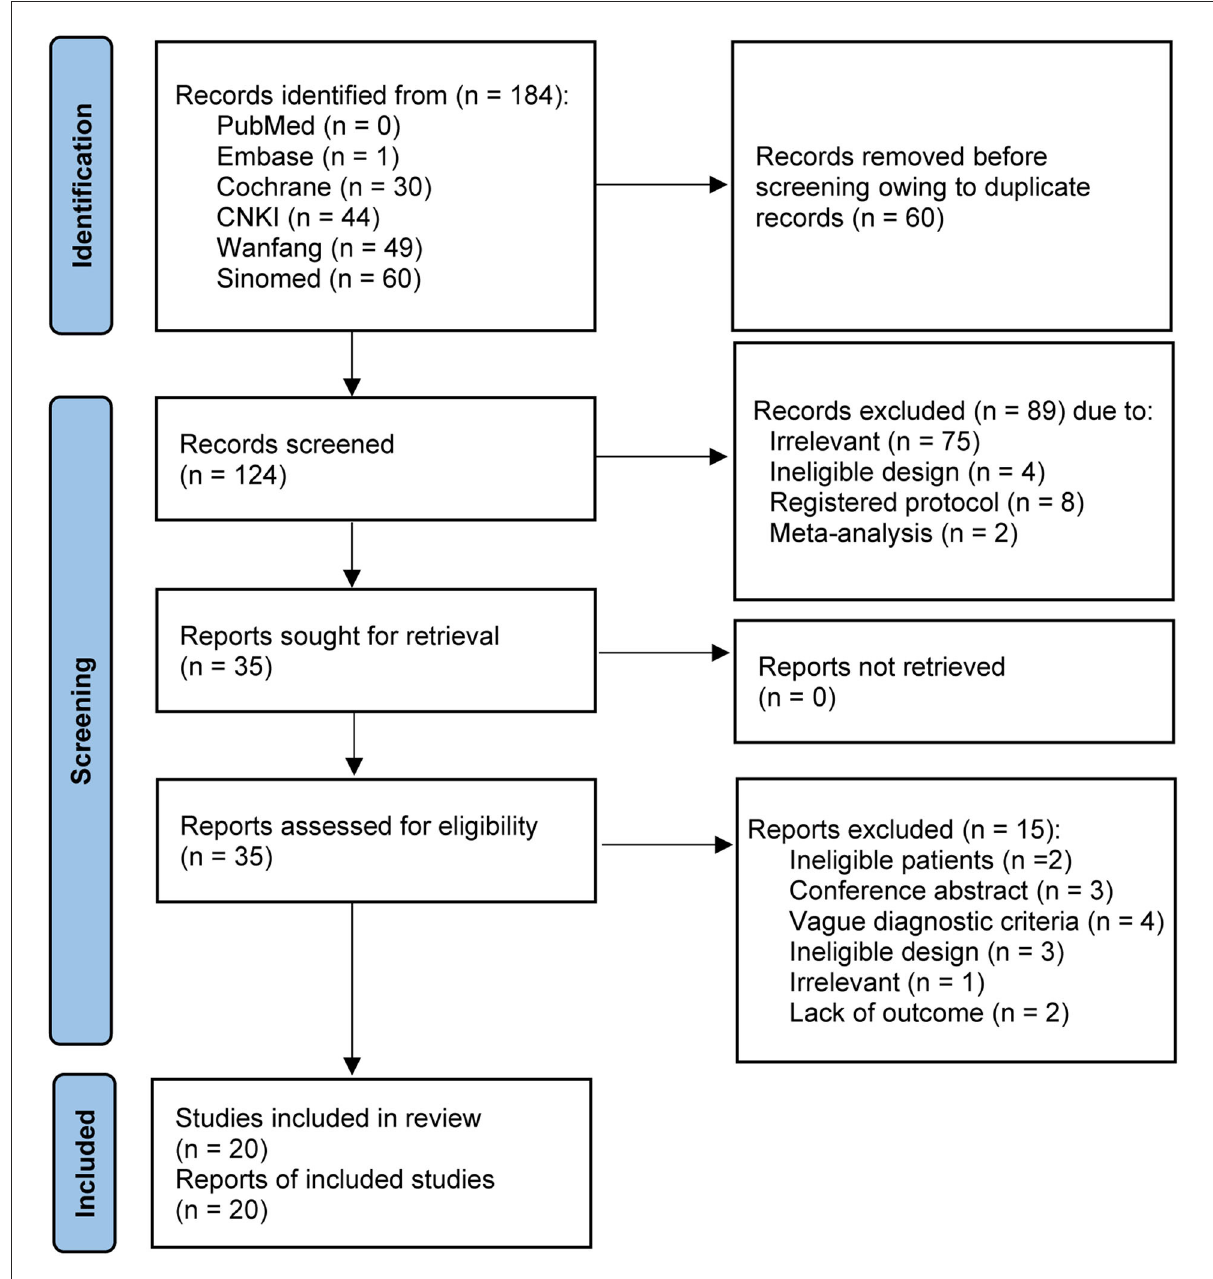
FIGURE1 PRISMA flow chart of study identification and selection. CNKI, China National Knowledge Infrastructure. Sinomed, Chinese Biomedical Literature Database.